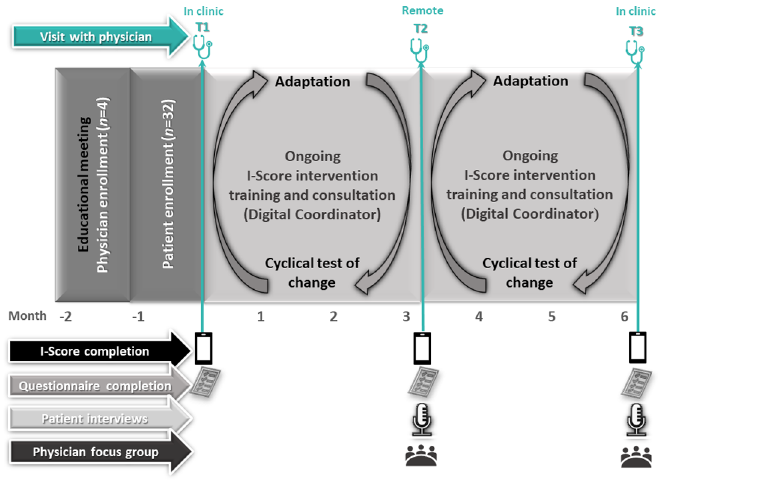
Fig 3. Pilot study